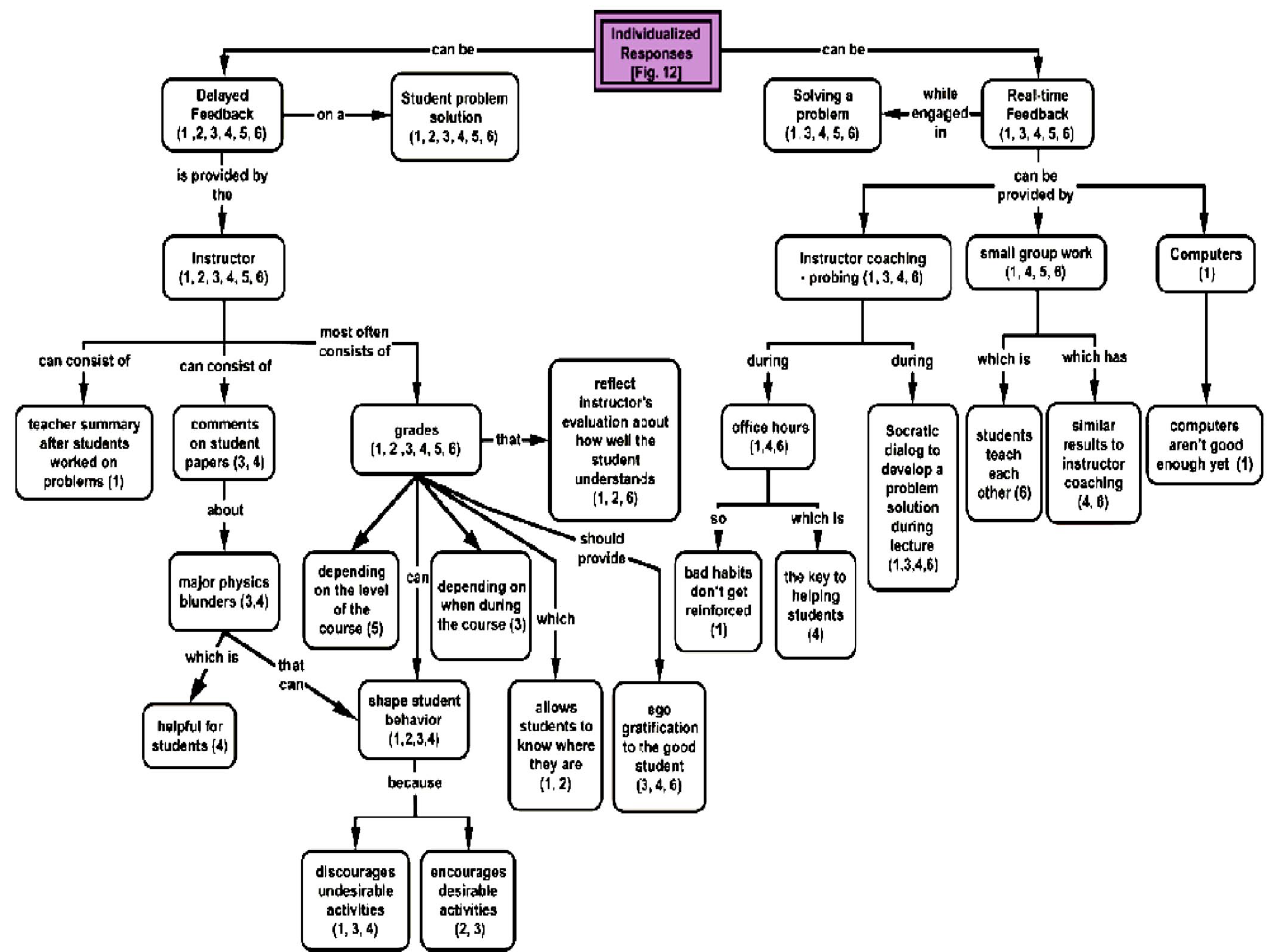
FIG. 12. (cid:1) Color (cid:2) Values part of composite map “Individualized Response” concerned with faculty beliefs about the appropriate structure of individualized response in their introductory physics course. Numbers in the parentheses denote the instructor whose statements directly justify that